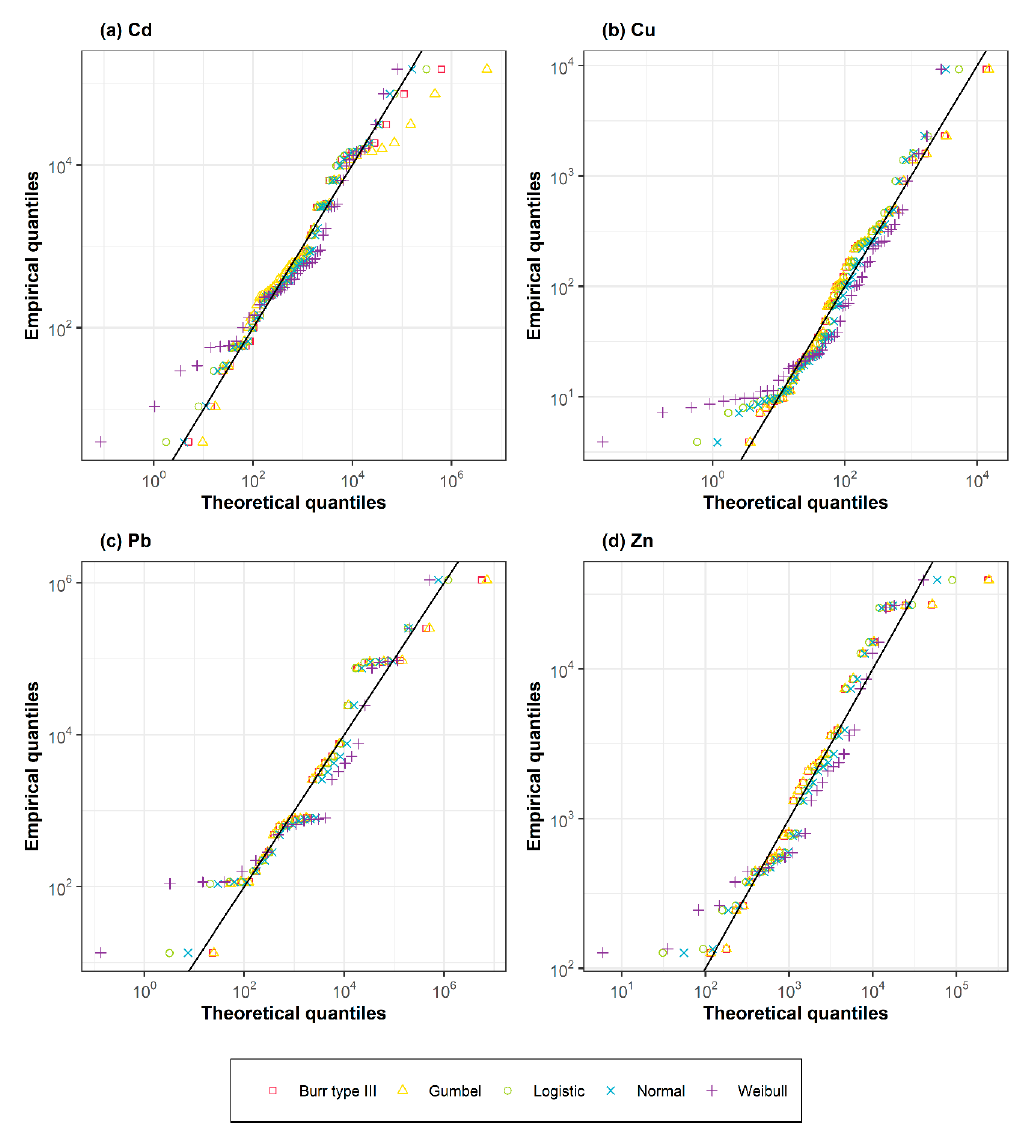
Figure 3. Quantile–Quantile (Q–Q) plots of the distribution models for ( a ) Cd, ( b ) Cu, ( c ) Pb, and ( d ) Zn